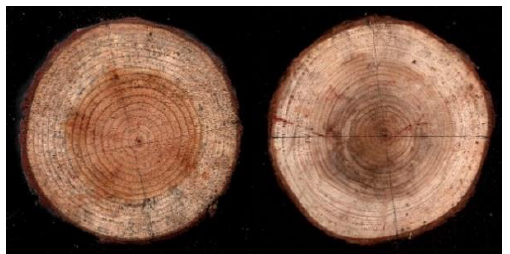
Figure 10. Larch #6 discs (left) and fir #5 discs (right).